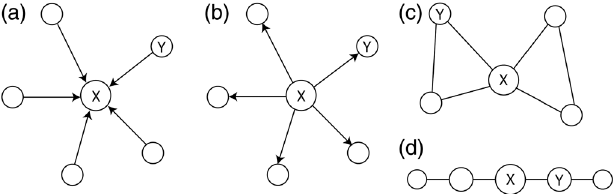
FIG. 2. Visualization of various types of centralities. In each case, X has higher centrality than Y according to (a) indegree (can be thought of as a measure of, e.g., popularity), (b) outdegree (can be thought of as a measure of, e.g., sociability or influence), (c) closeness (a measure of overall connectivity or embeddedness within the entire network), and (d) betweenness (a measure of control over the flow of, e.g., information through the entire network). Adapted from Ref.